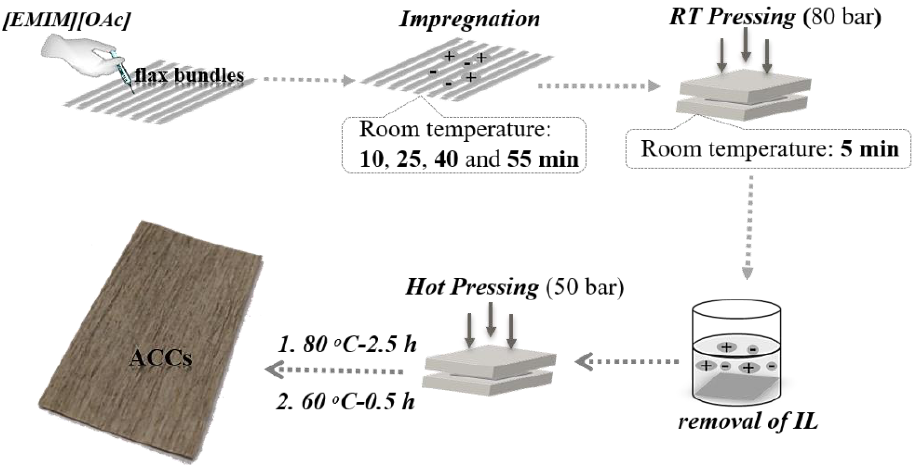
Figure 1. Manufacturing scheme for ACCs and examples of ACCs obtained.